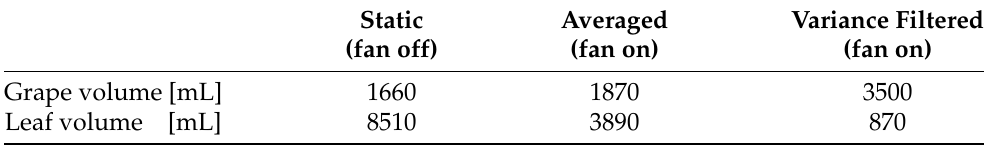
Table 3. Grape and foliage volume estimates using ultrasonic far-field array